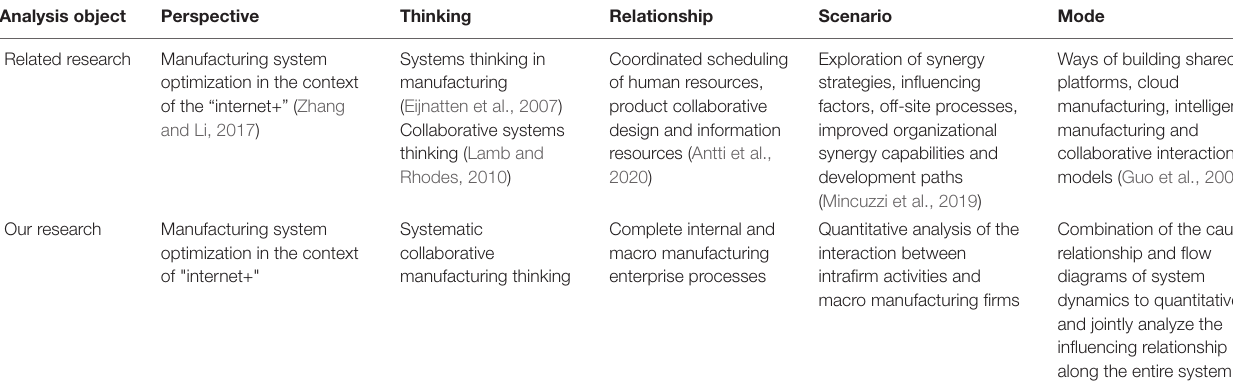
TABLE 7 | Comparative analysis of the research